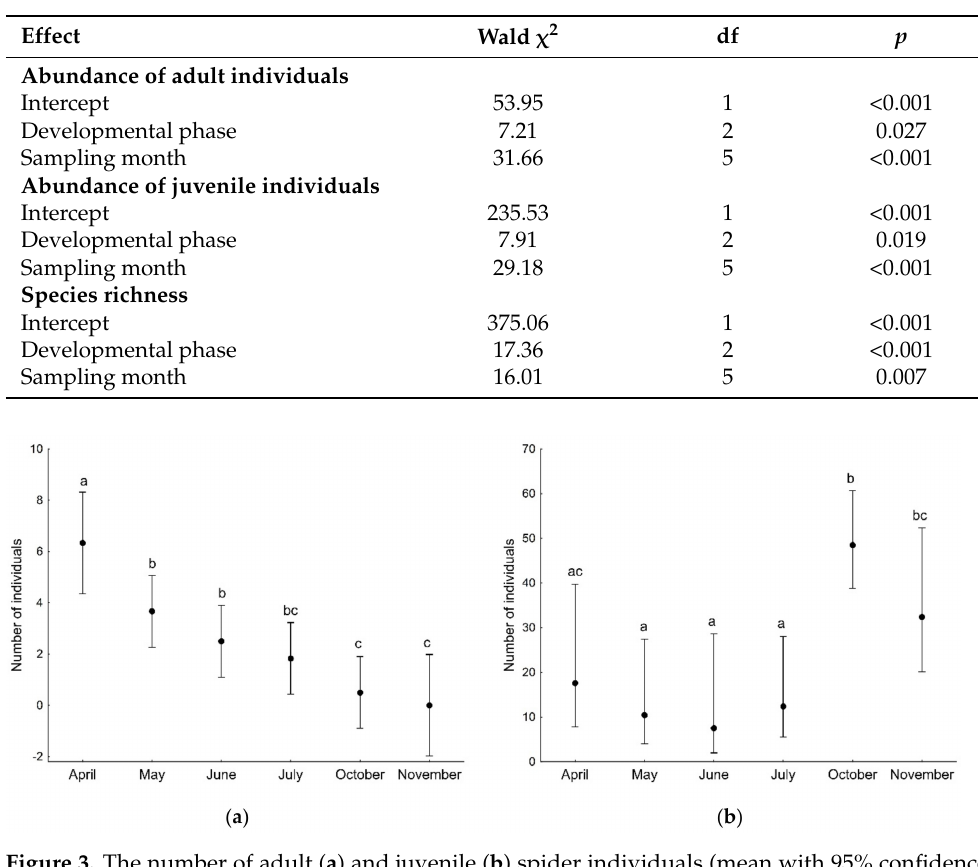
Table 3. Results of generalised linear models assessing the effect of the developmental phase of the tree stand and sampling month on the abundance and the species richness of spider assemblages of tree branches.